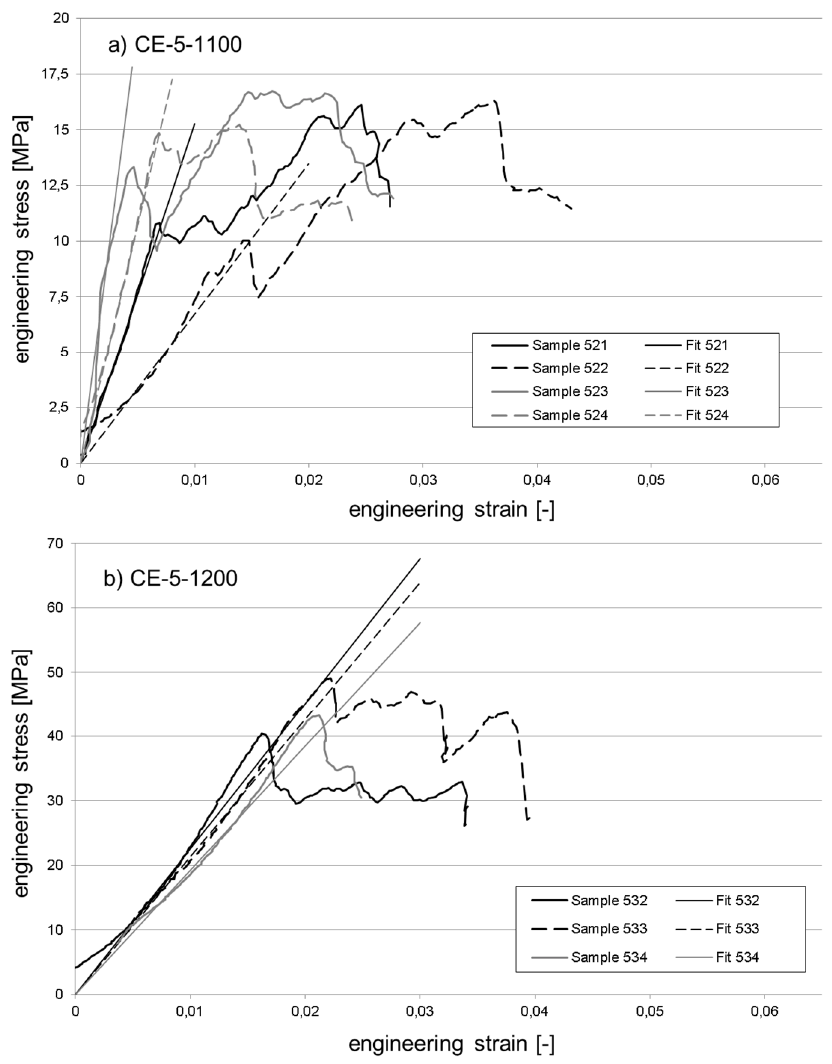
Figure 11. Exemplary stress strain curves for the syntactic foams containing 50 vol % cenospheres: ( a ) firing temperature 1100 °C; ( b ) firing temperature 1200 °C. Table 2. Overview of Young’s modulus values obtained from the stress-strain curves exhibited in Figures 10 and